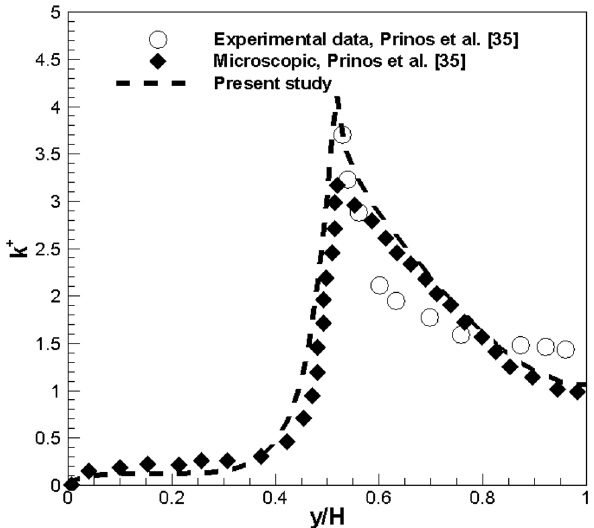
Fig. 3 A comparison of the macroscopic turbulent viscosity with the results of Prinos et al. [35]